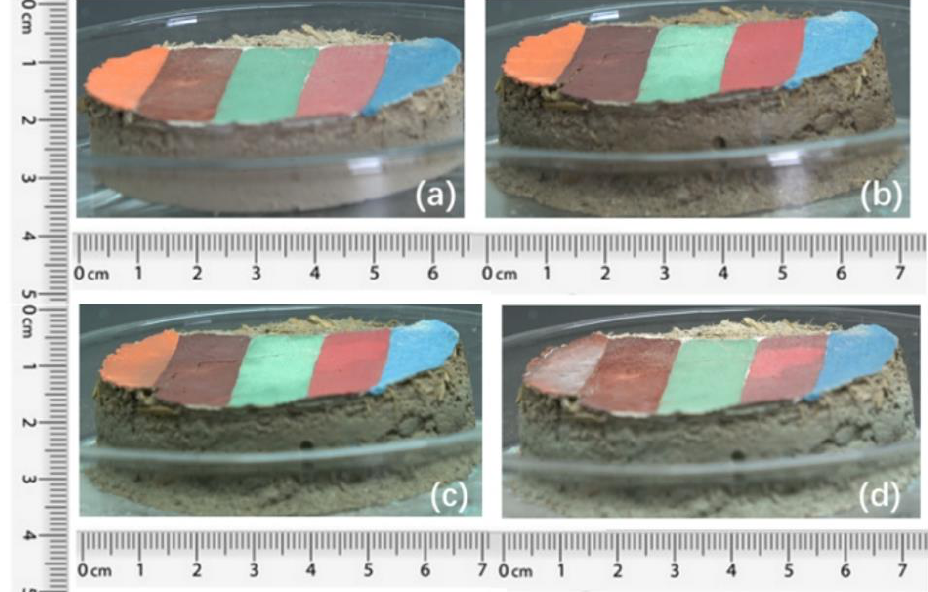
Figure 9. The processes of change as the sample consisting of coarse plaster and paint layers absorbed the solution then dried out: ( a ) untreated sample; ( b ) after absorbing salt solution for 54 min; ( c ) after losing water and shrinking for 6 h; ( d ) after drying for 30 h.